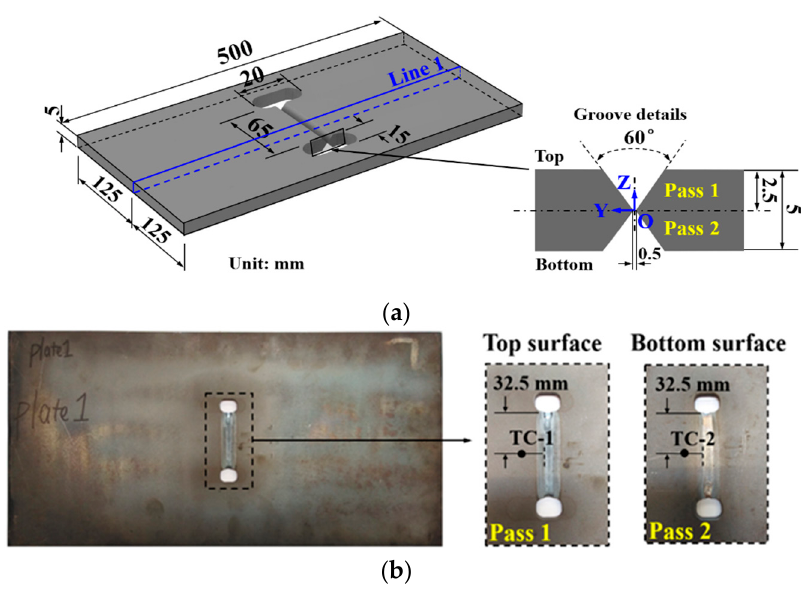
Figure 5. The dimension of the experimental mock-up: ( a ) Schematic diagram; ( b ) experimental specimen.